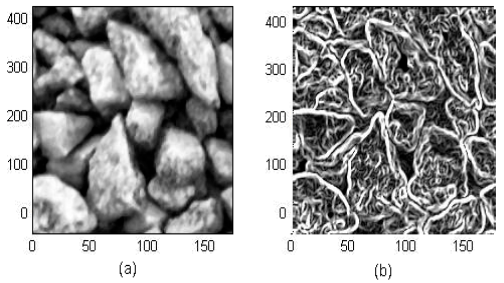
Figure 3. ( a ) Original image; ( b ) application of the Sobel operator in ( a ).